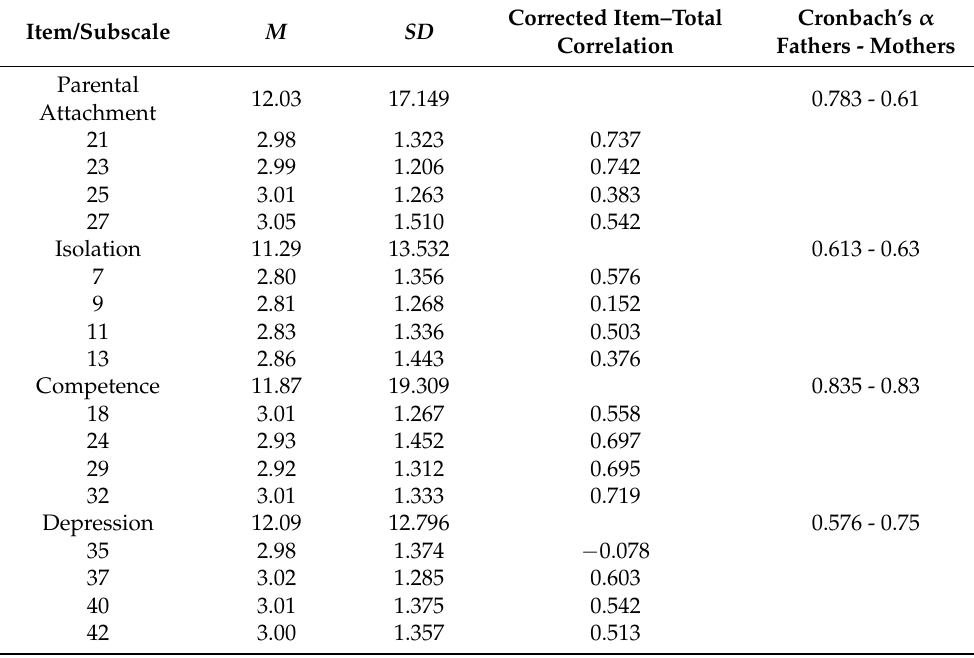
Table 3. Item analysis of the EBI regarding Parent Characteristics for